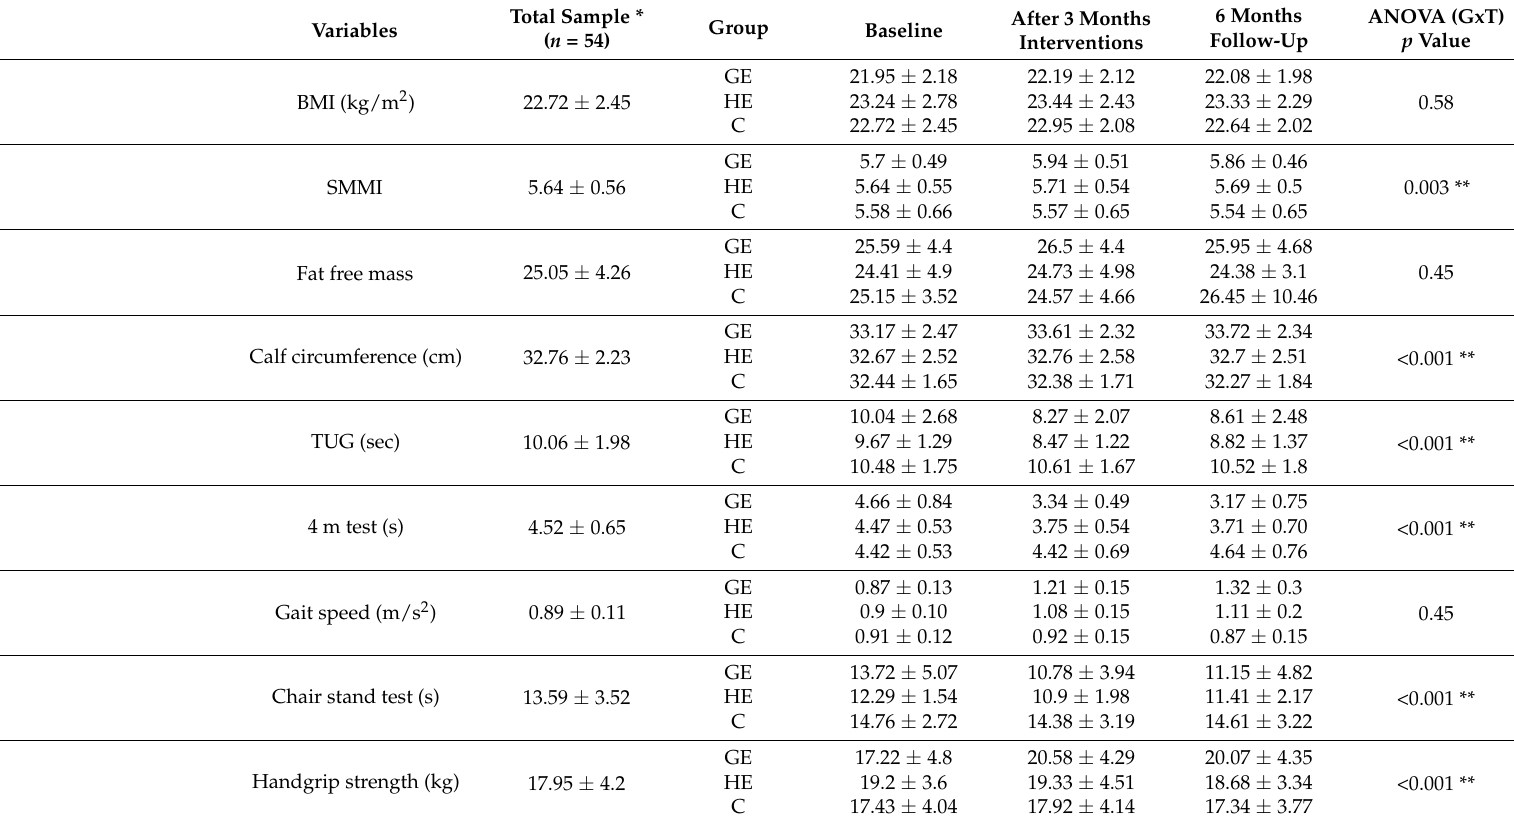
Table 3. Comparisons of variables among